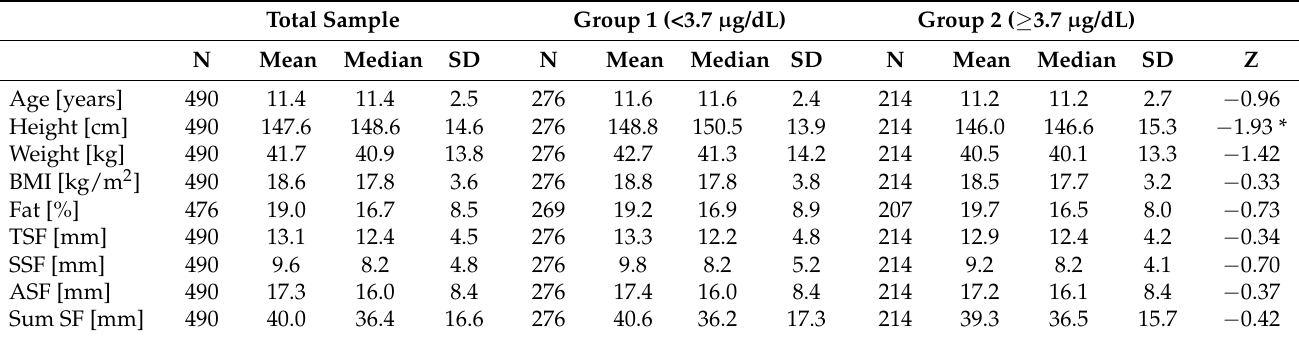
Table 2. Anthropometric characteristics of the total sample of girls and of the groups of blood Pb levels, as well as the results of Mann–Whitney U tests (comparing the two blood Pb level groups). Total Sample Group 1 (<3.7 µ g/dL) Group 2 ( ≥ 3.7 µ g/dL)